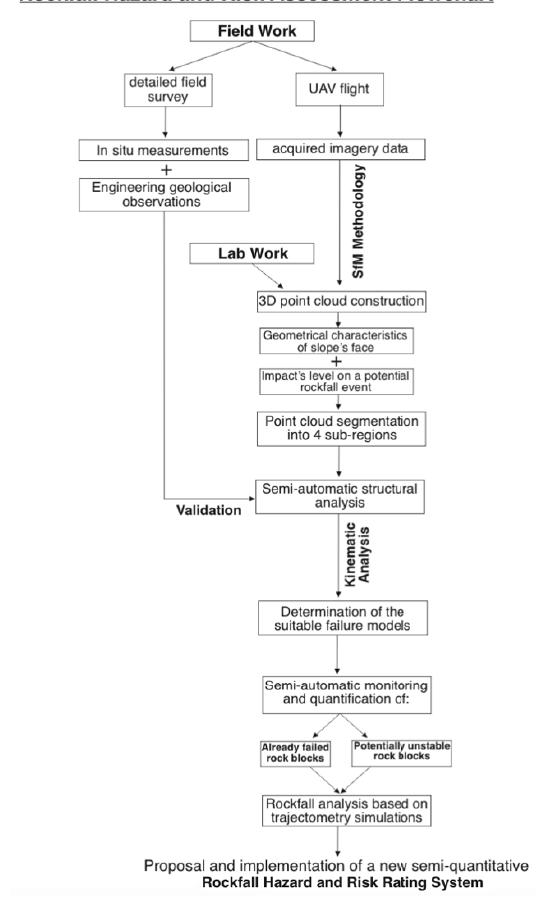
Figure 1. Conceptual scheme of the proposed methodology.